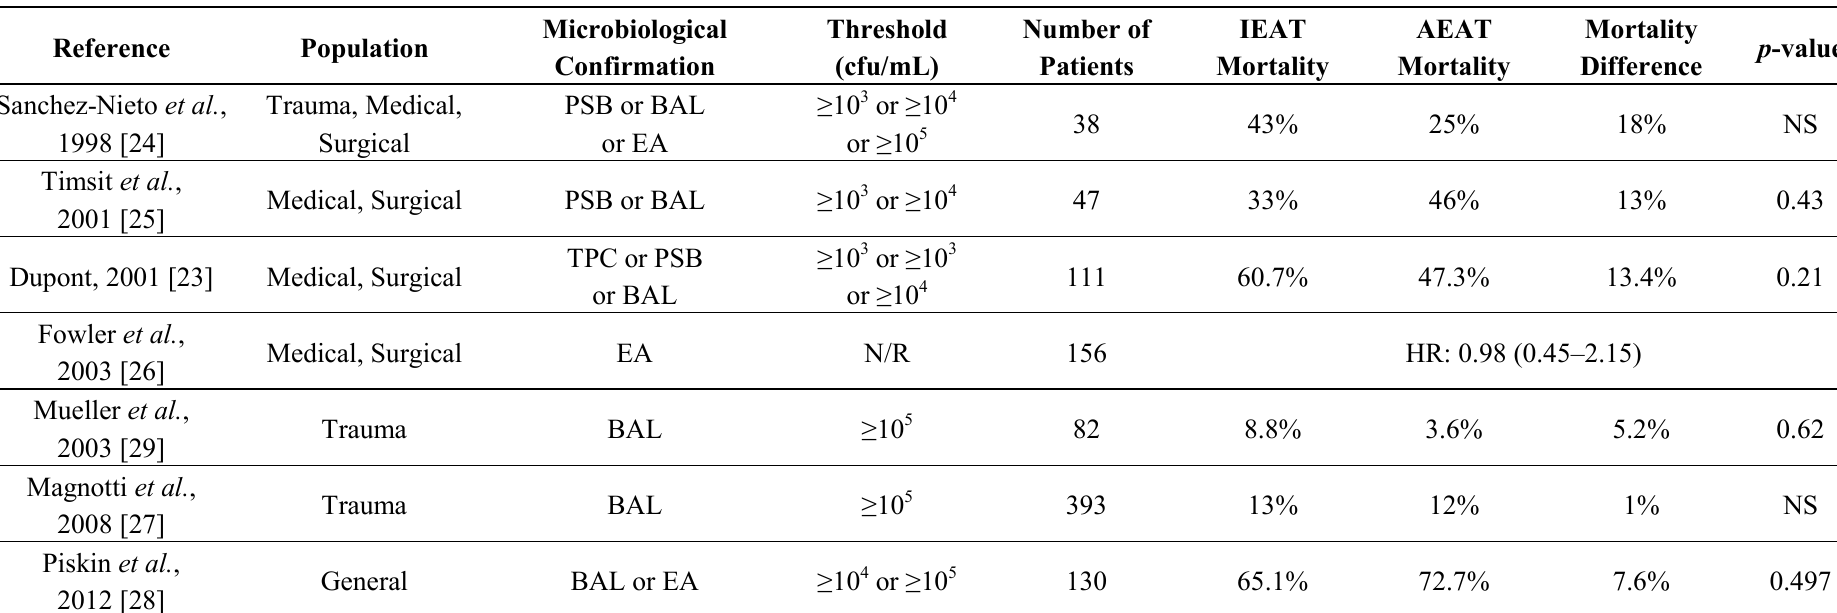
Table 2. Studies showing no benefit of appropriate empiric